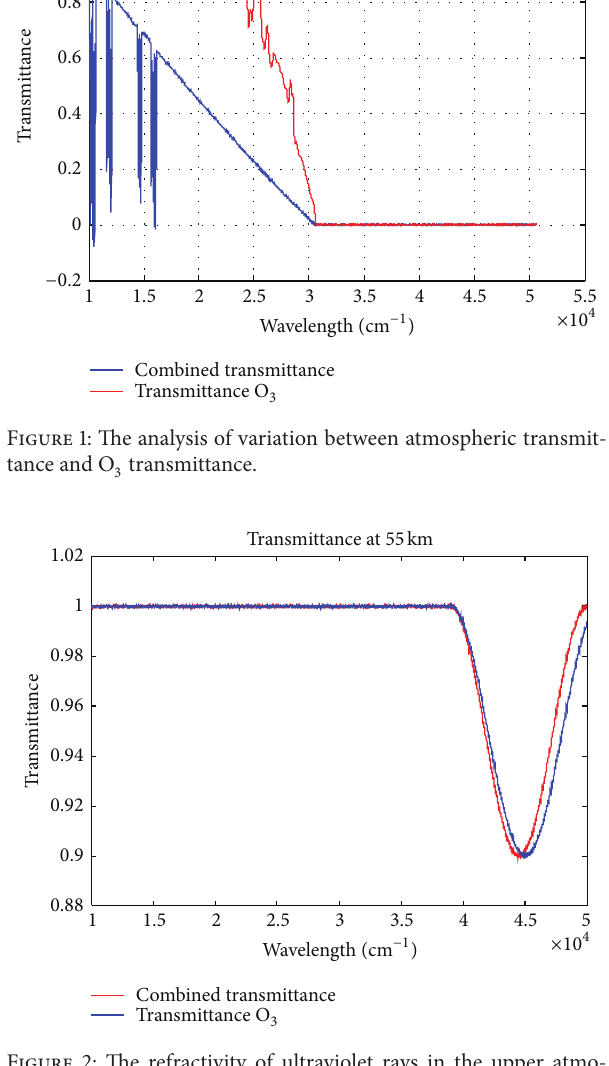
Figure 2: The refractivity of ultraviolet rays in the upper atmo-